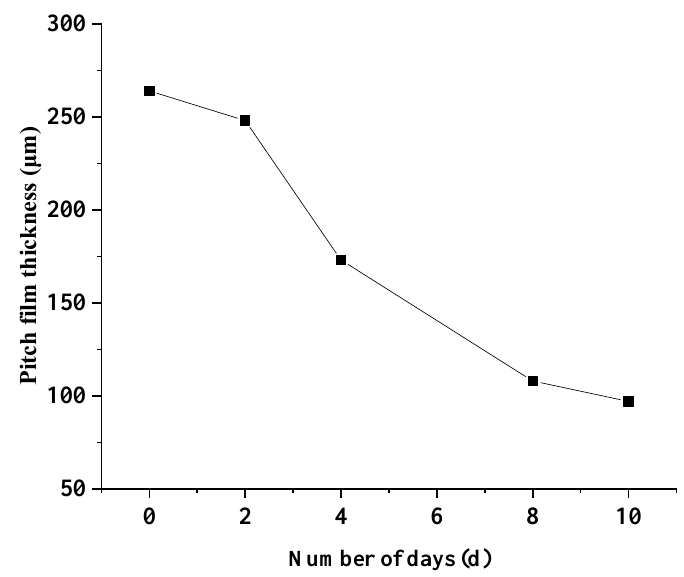
Figure 7. Simulated changes in asphalt thickness in an outdoor environment.